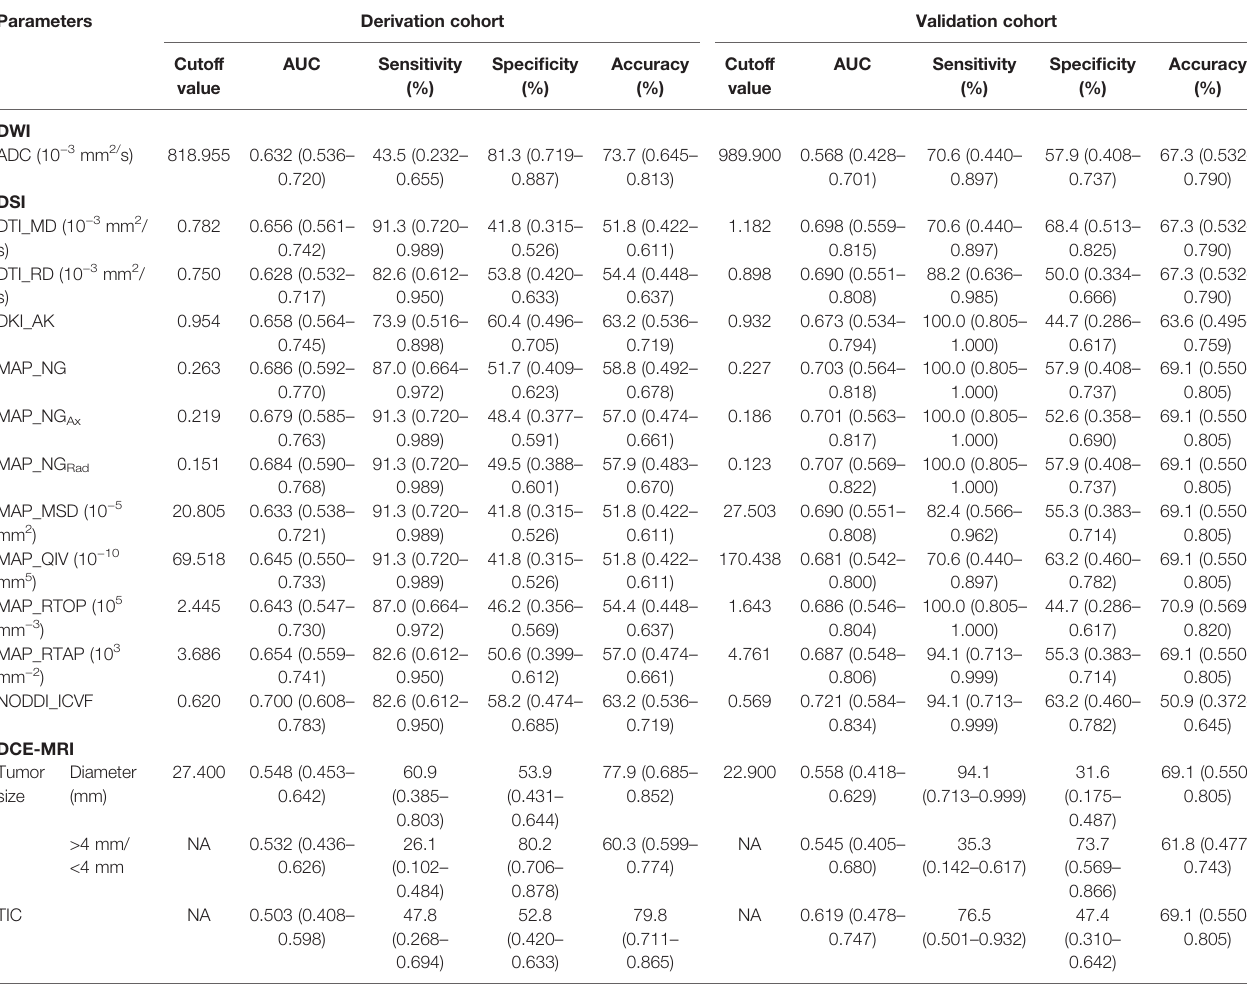
TABLE 4 | ROC analyses of conventional MRI and quantitative DSI parameters in discriminating HER2 status in patients with breast cancer.